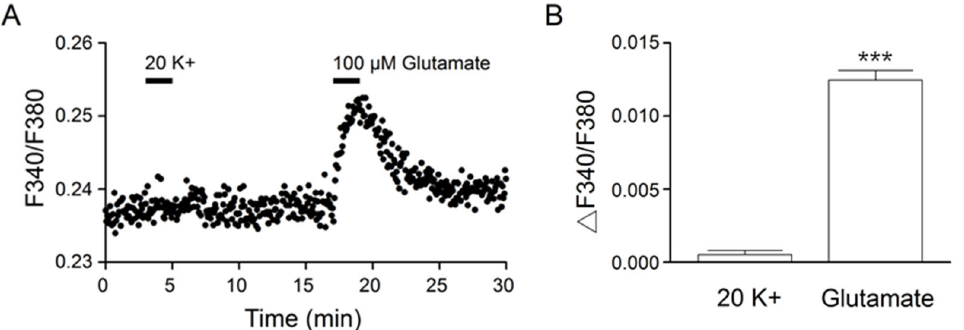
Figure 3. Na 2+ responses to 20 mM K + and 100 µ M glutamate. ( A ) A representative experiment showing the Na + responses elicited by 2 min application of 20 mM K + and 100 µ M glutamate (an average of 12 cells). Note the approximately linear increase in the glutamate-induced Na + loads. ( B ) Statistics showing the average increase in [Na + ] i in response to 20 mM K + and 100 µ M glutamate. *** p < 0.0001.